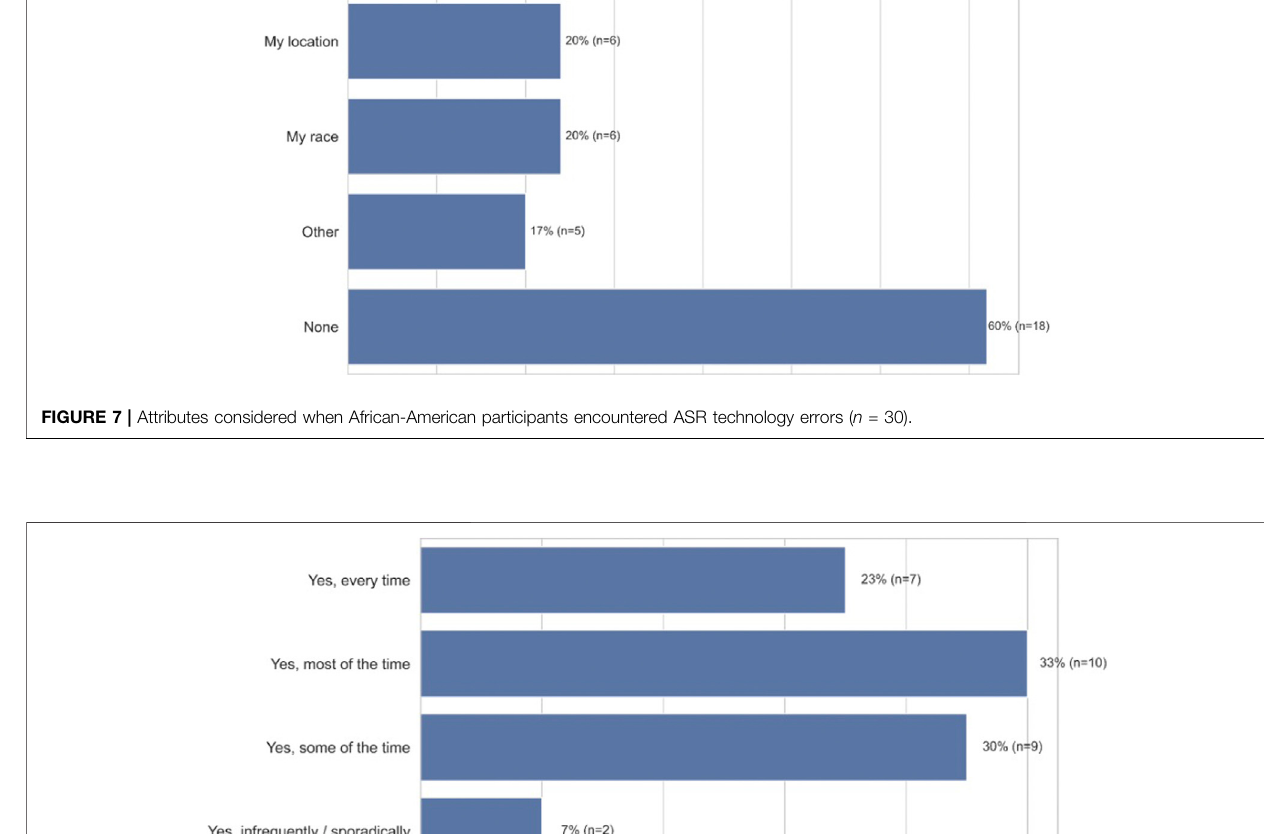
( Figure 9 , closed-ended question responses). As before,